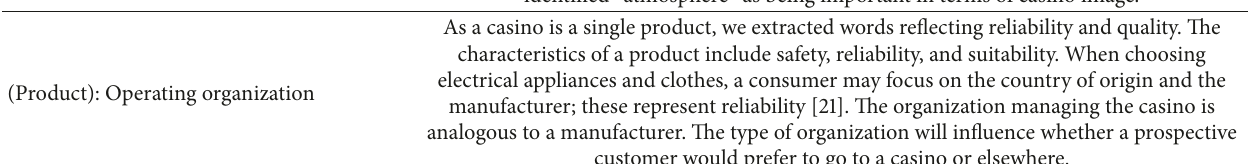
Extraction protocol